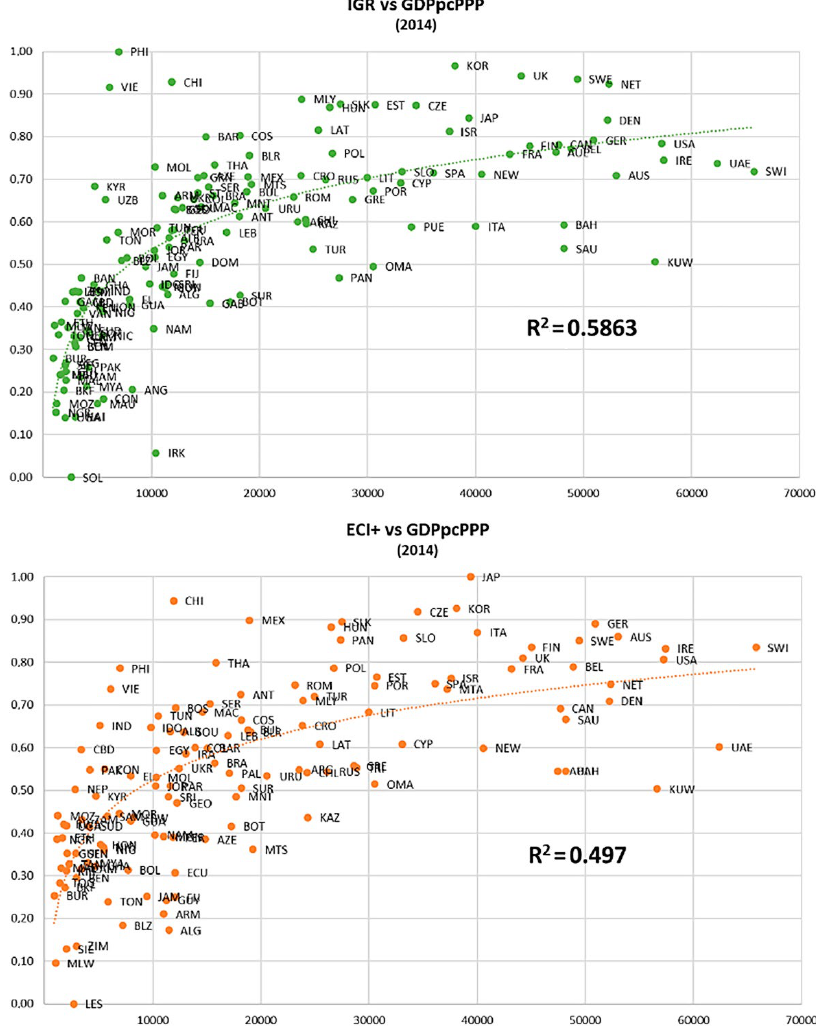
Figure 1. IGR vs GDPpcPPP 2014 & ECI+ vs GDPpcPPP